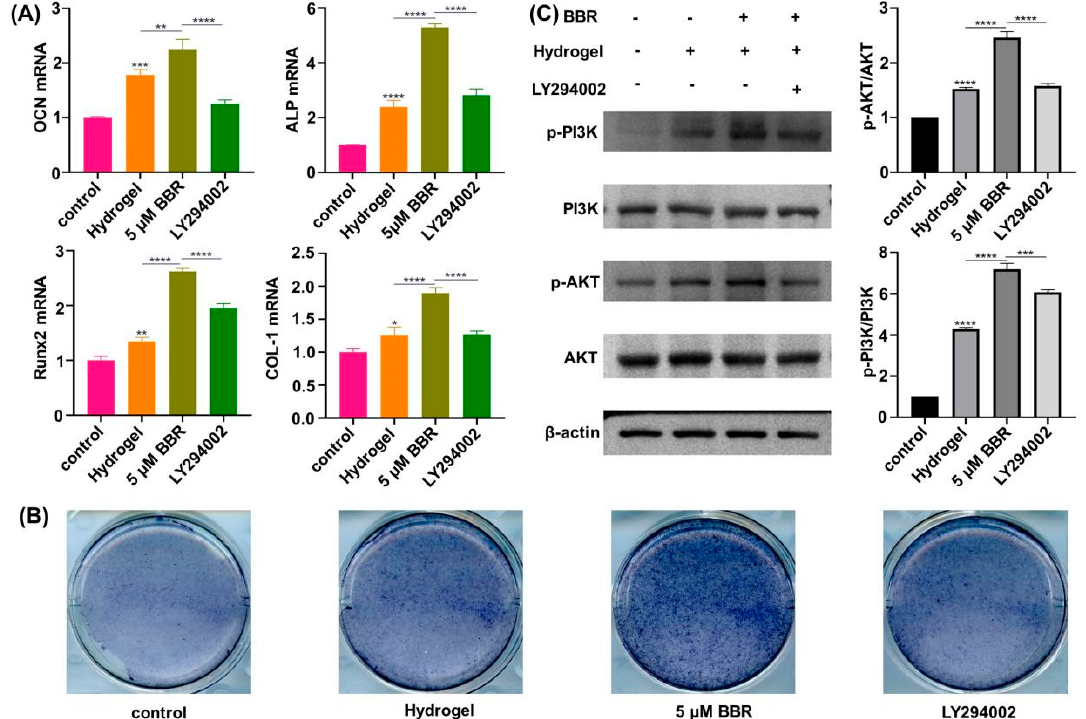
Figure 5. Osteogenesis effect of berberine thermosensitive hydrogel. ( A ) Change of ALP, COL − 1, OCN, Runx − 2 mRNA expression; ( B ) Alkaline phosphatase staining results; ( C ) Protein changes in the PI3K/AKT pathway. *: p < 0.05, **: p < 0.01, ***: p < 0.001, ****: p < 0.0001.